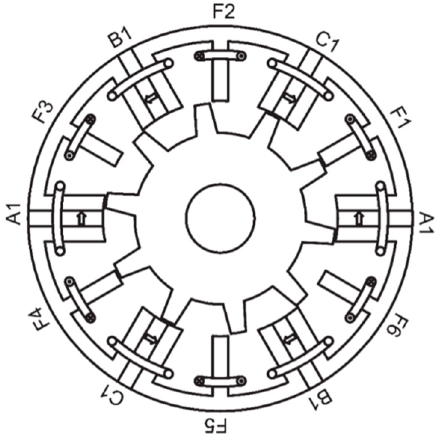
Figure 14. Schematic of an E-core hybrid FSPM machine [36].